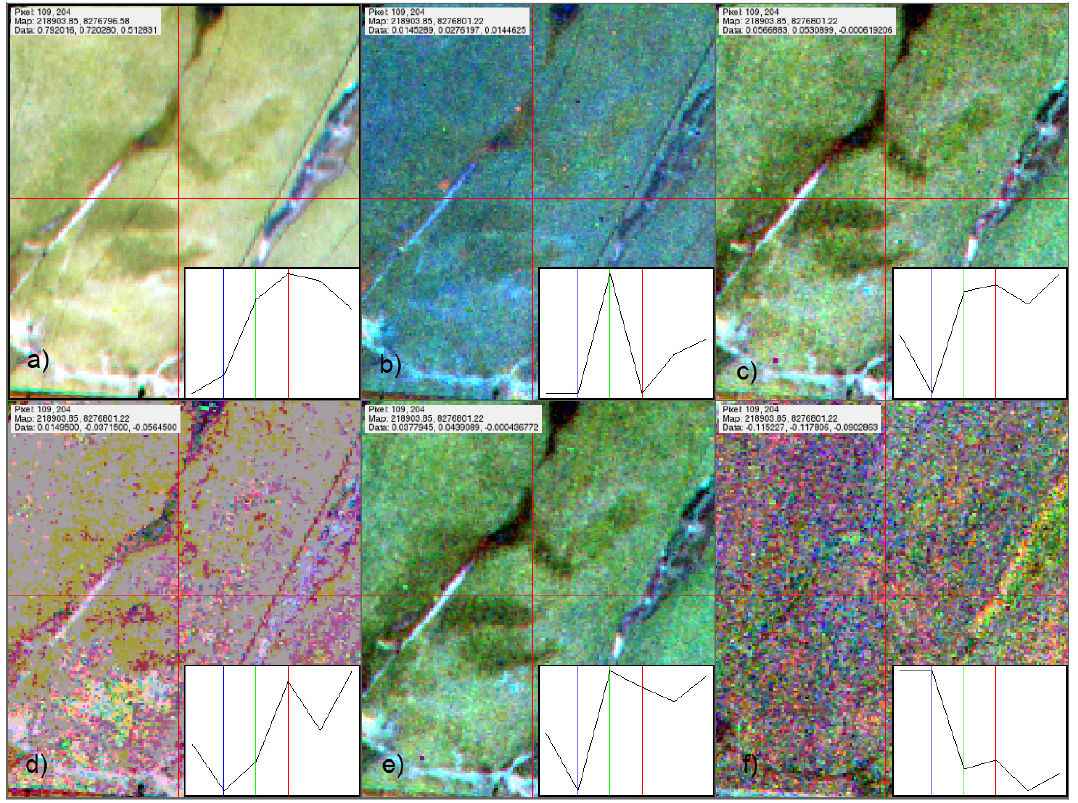
Figure 5. Screenshot of the temporal profiles of the six spectral indices plotted in RGB (Red-Green-Blue: 2007-02-10; 2006-11-19; 2006-09-13), with central pixel profiles displayed in the respective lower right corner: ( a ) NDVI; ( b ) MCARI; ( c ) LWVI2; ( d ) CAI; ( e ) NDLI; and ( f ) NDNI, as visualized in the EnMAP-Box [64]. Particularly in the CAI and NDNI plots, it is possible to observe high level of noise in the data (due to the low SNR of